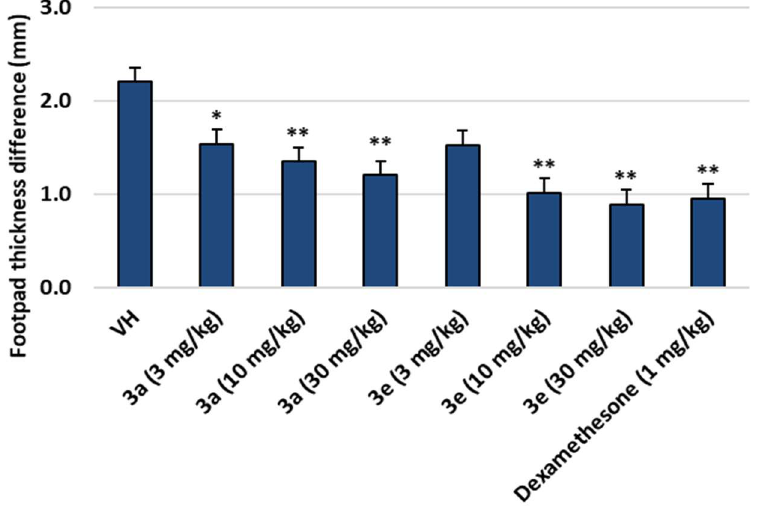
Figure 3. Footpad thickness differences in mice after treatment with compounds 3a and 3e (VH: zymosan A only). Data are presented as the mean ± SD. Student’s t-test was used for comparisons involving two groups. ( n = 8). * p < 0.05, ** p < 0.01 vs. VH.